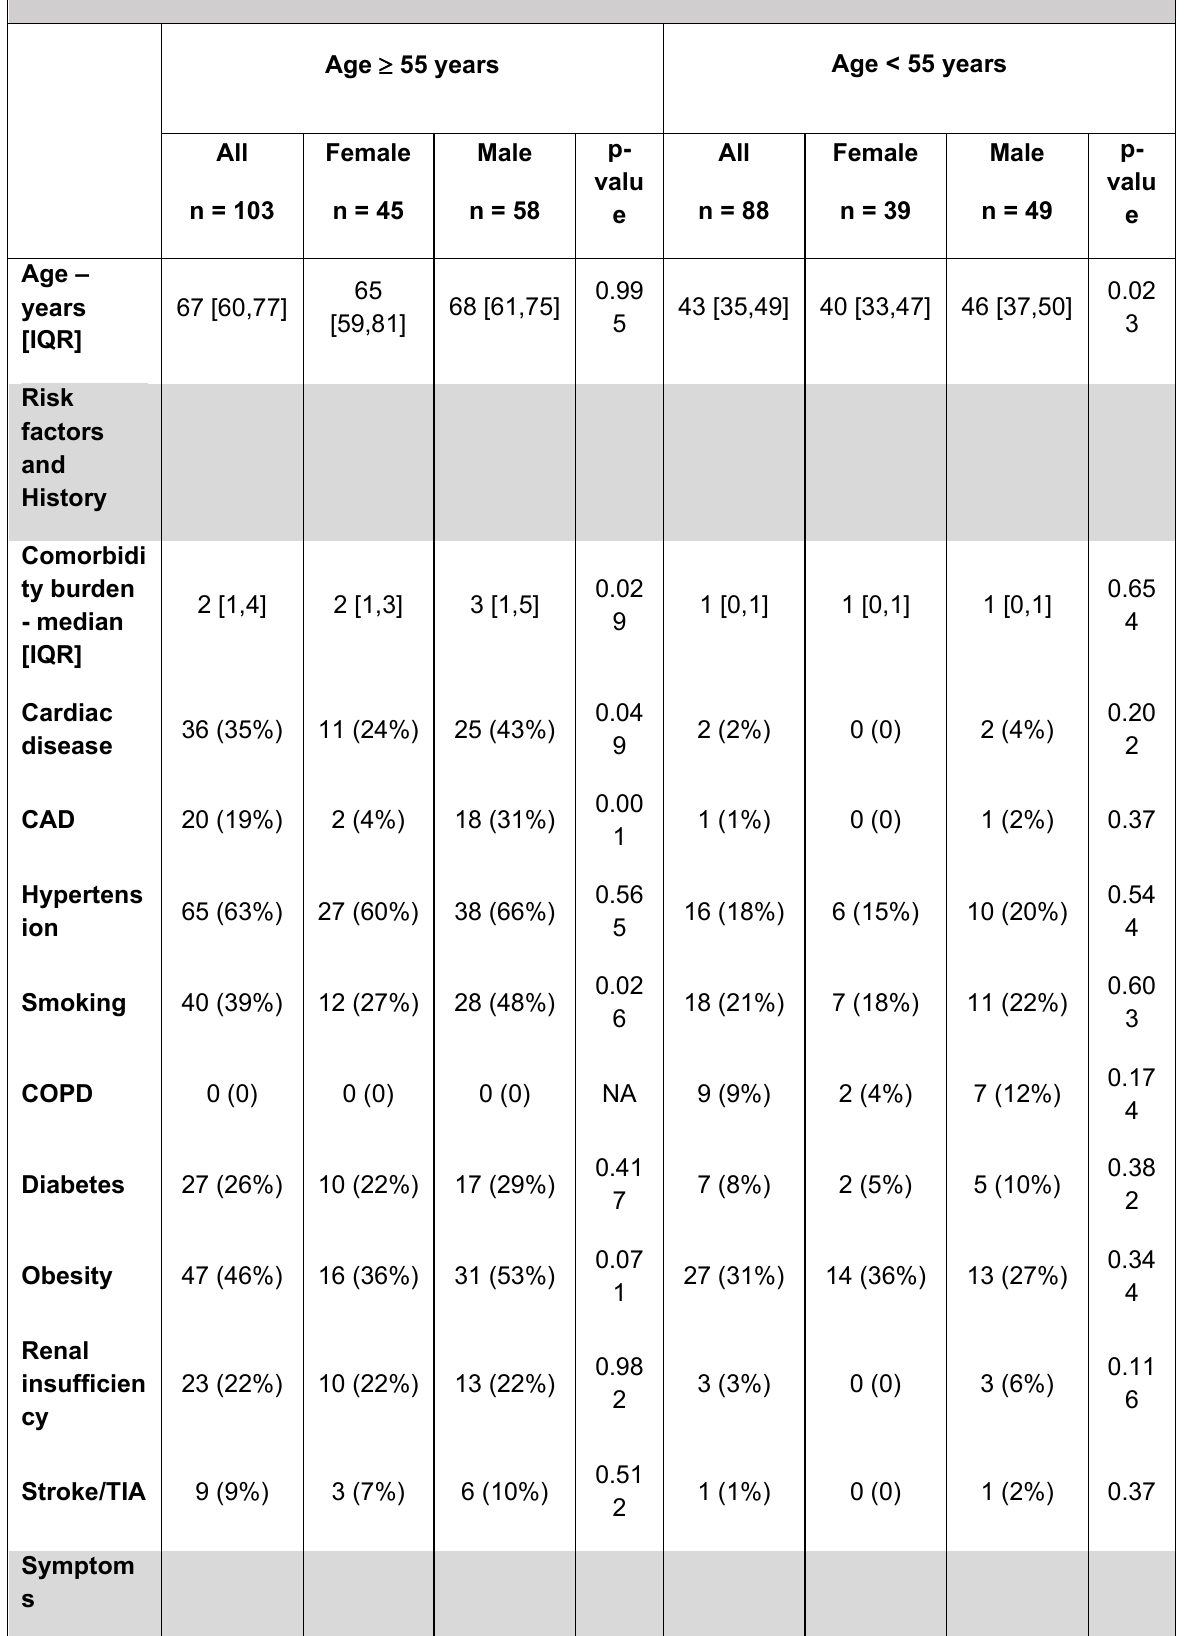
Table S4: Clinical characteristics in COVID-19 (cases